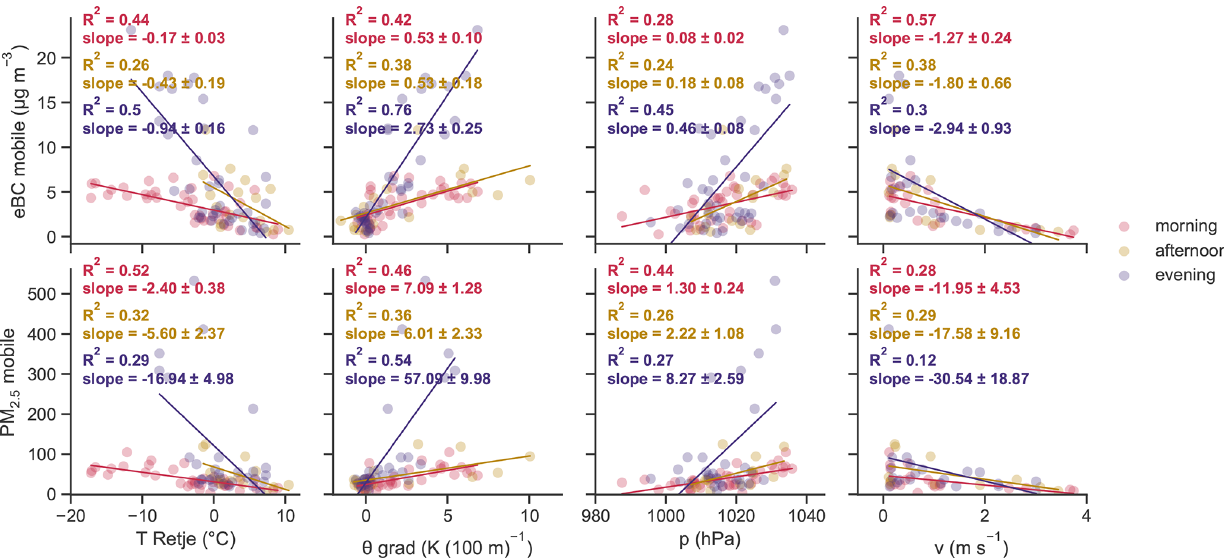
Figure 8. Linear correlations between the temperature measured at the Retje station ( T Retje), potential temperature gradient ( θ grad), atmospheric pressure ( p ), and wind speed measured at Hrib ( v ) with mobile eBC and PM 2 . 5 mass concentrations inside the cold air pool